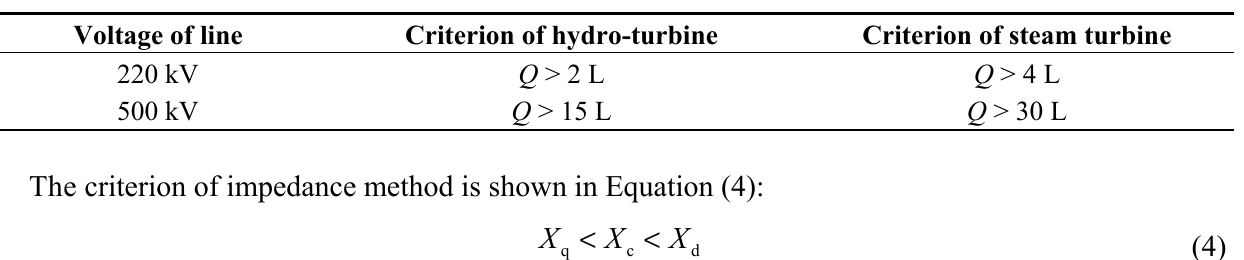
Table 2. Criterion of quick calculation